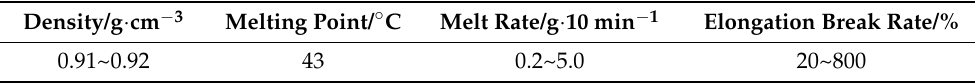
Table 3. Basic indicators of recycled PP pellets.